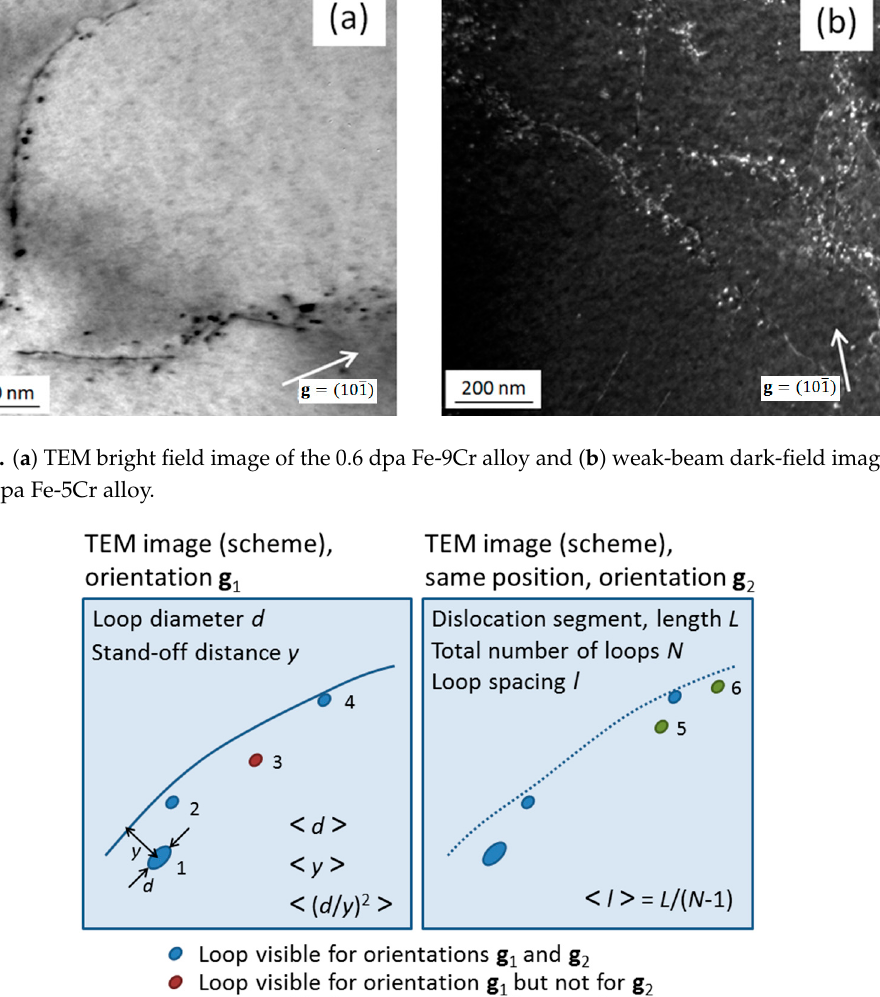
Figure 4. ( a ) TEM bright field image of the 0.6 dpa Fe-9Cr alloy and ( b ) weak-beam dark-field image of the 0.6 dpa Fe-5Cr alloy.